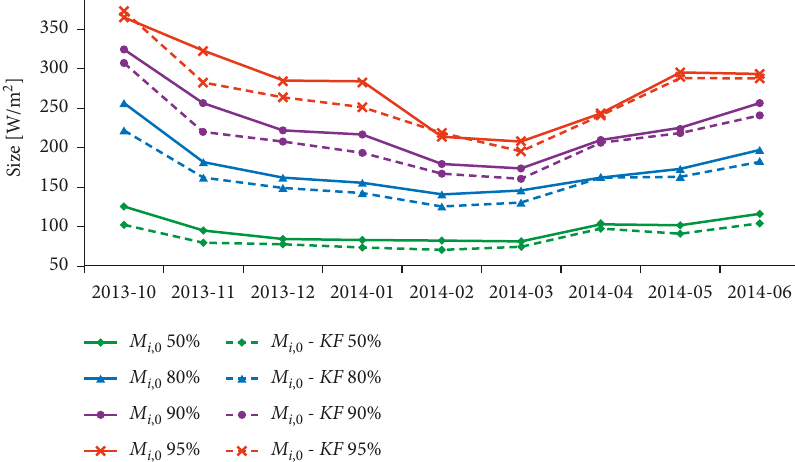
Figure 12: Monthly sizes of prediction interval for the intraday solar GHI prediction with regard to the prediction interval of the ensemble prediction during the period from October 2013 to June